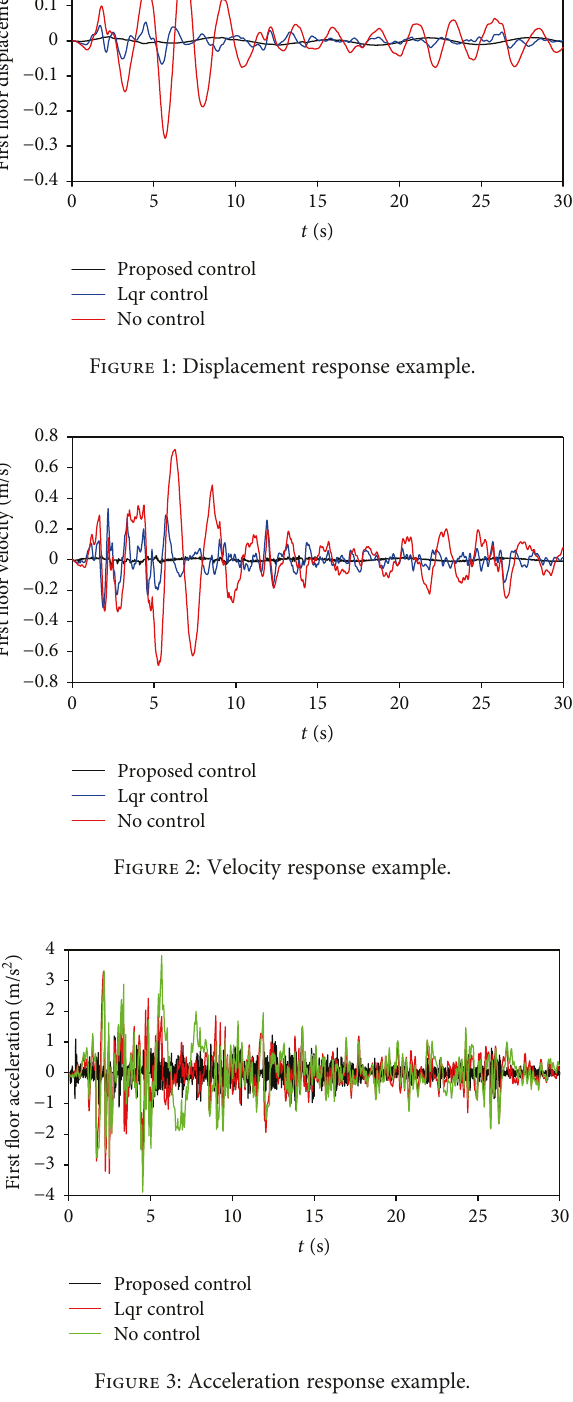
Figure 3: Acceleration response example.